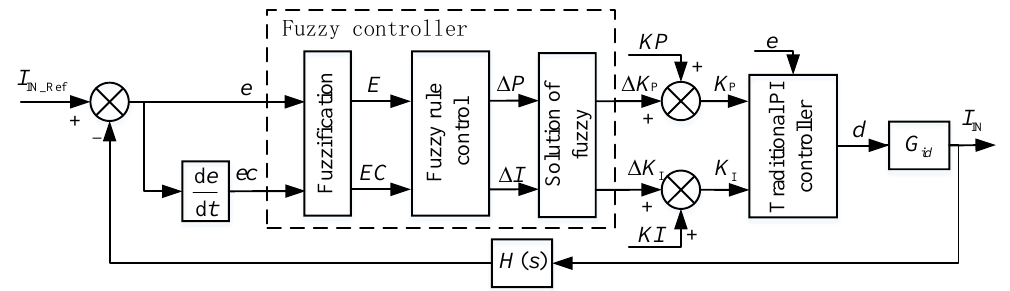
Figure 6. Input-current-tracking algorithm based on fuzzy control block diagram.